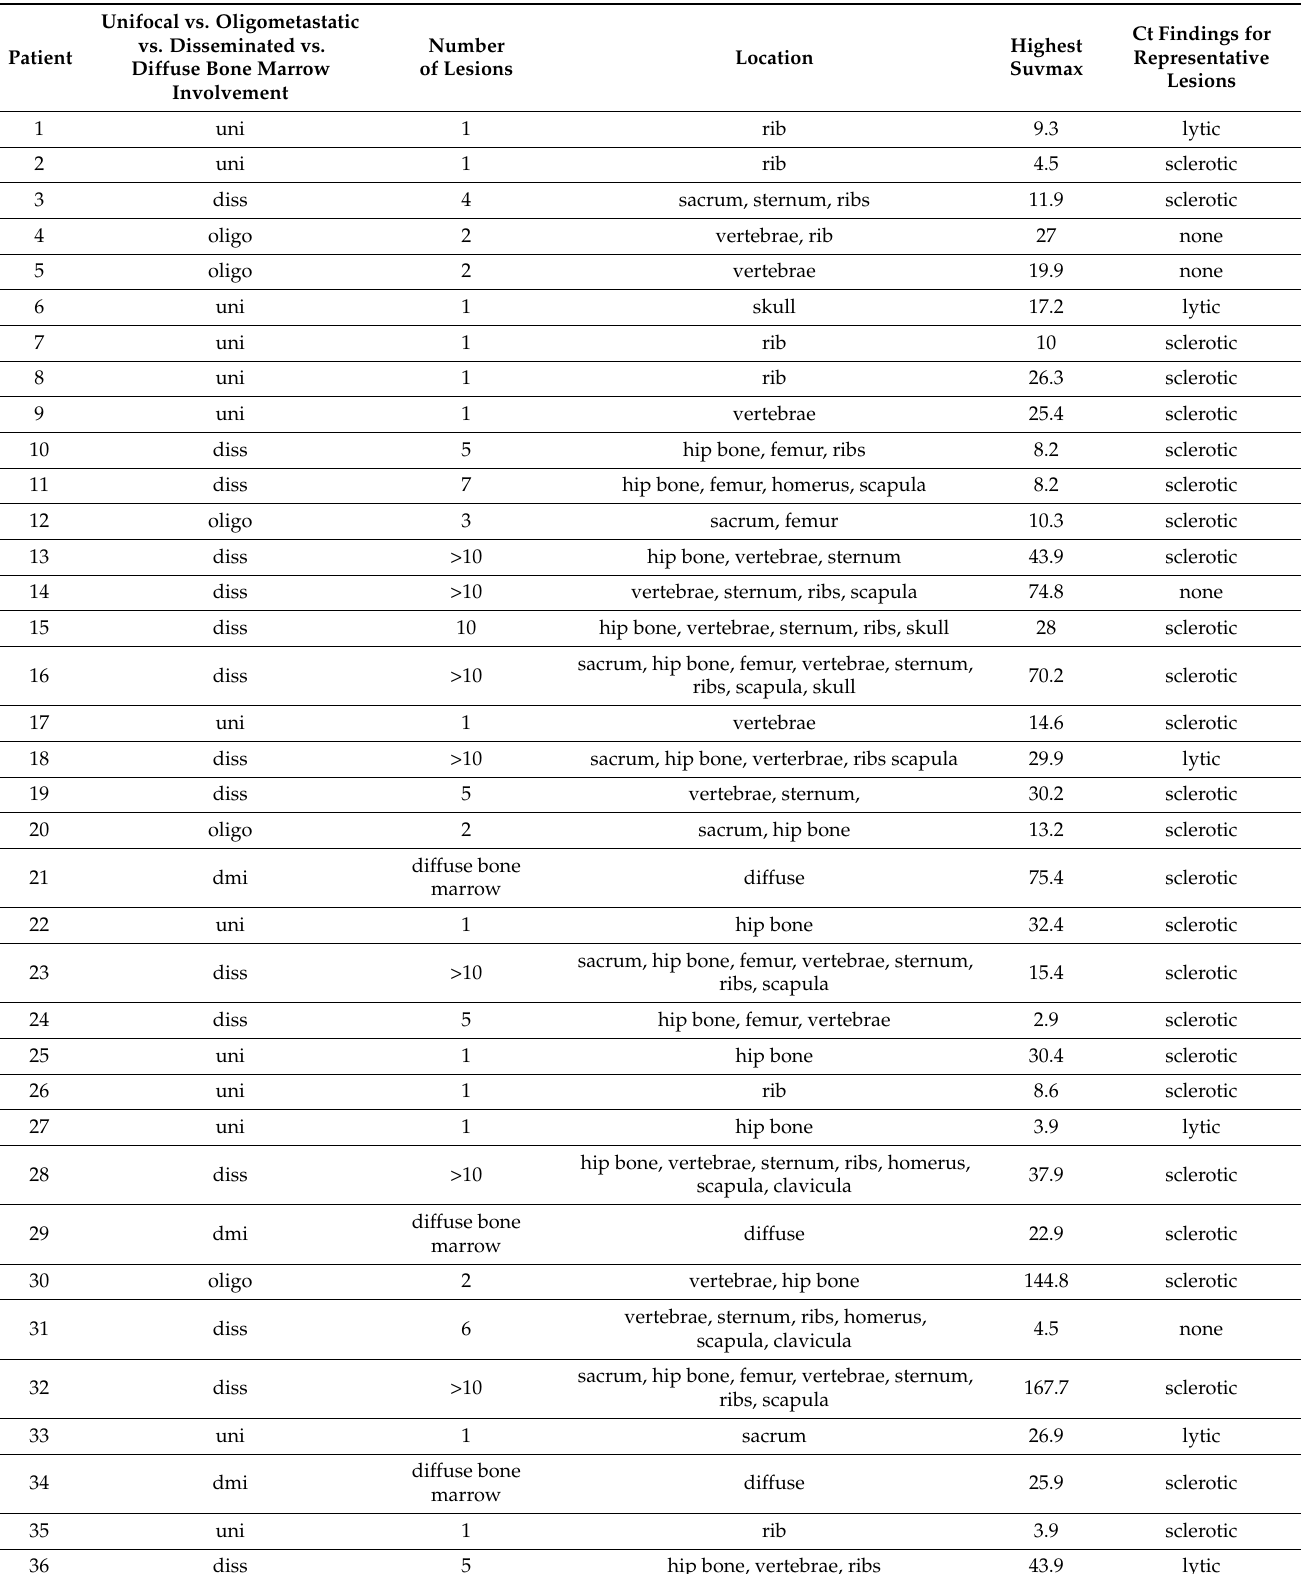
Table 2. Per patient localizations of PSMA bone